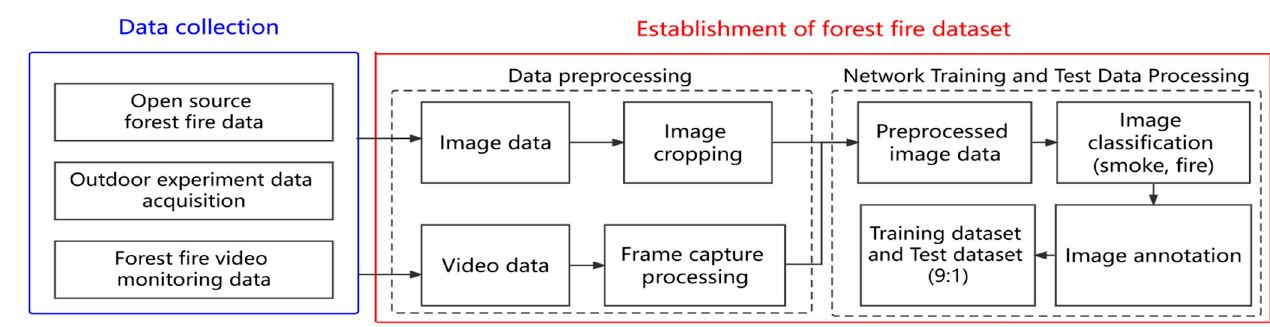
Figure 2. The data processing flow for forest fire dataset.